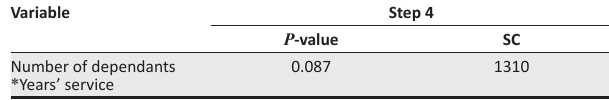
TABLE 4: Variable interaction Schwarz